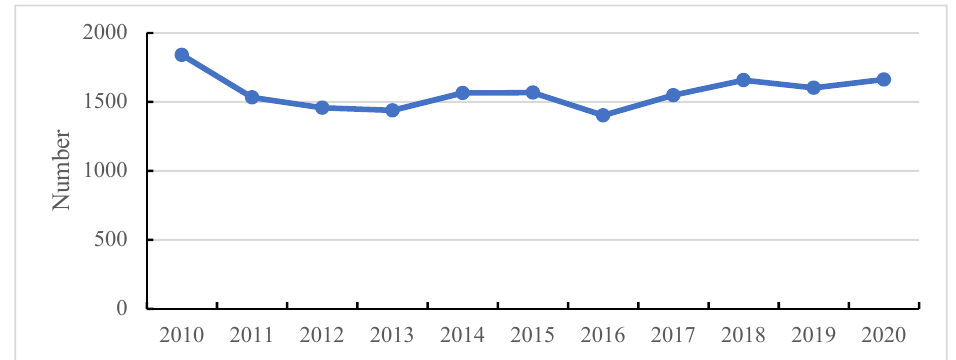
Figure 1. Maritime shipping accidents that occurred in the 2010–2020 period.